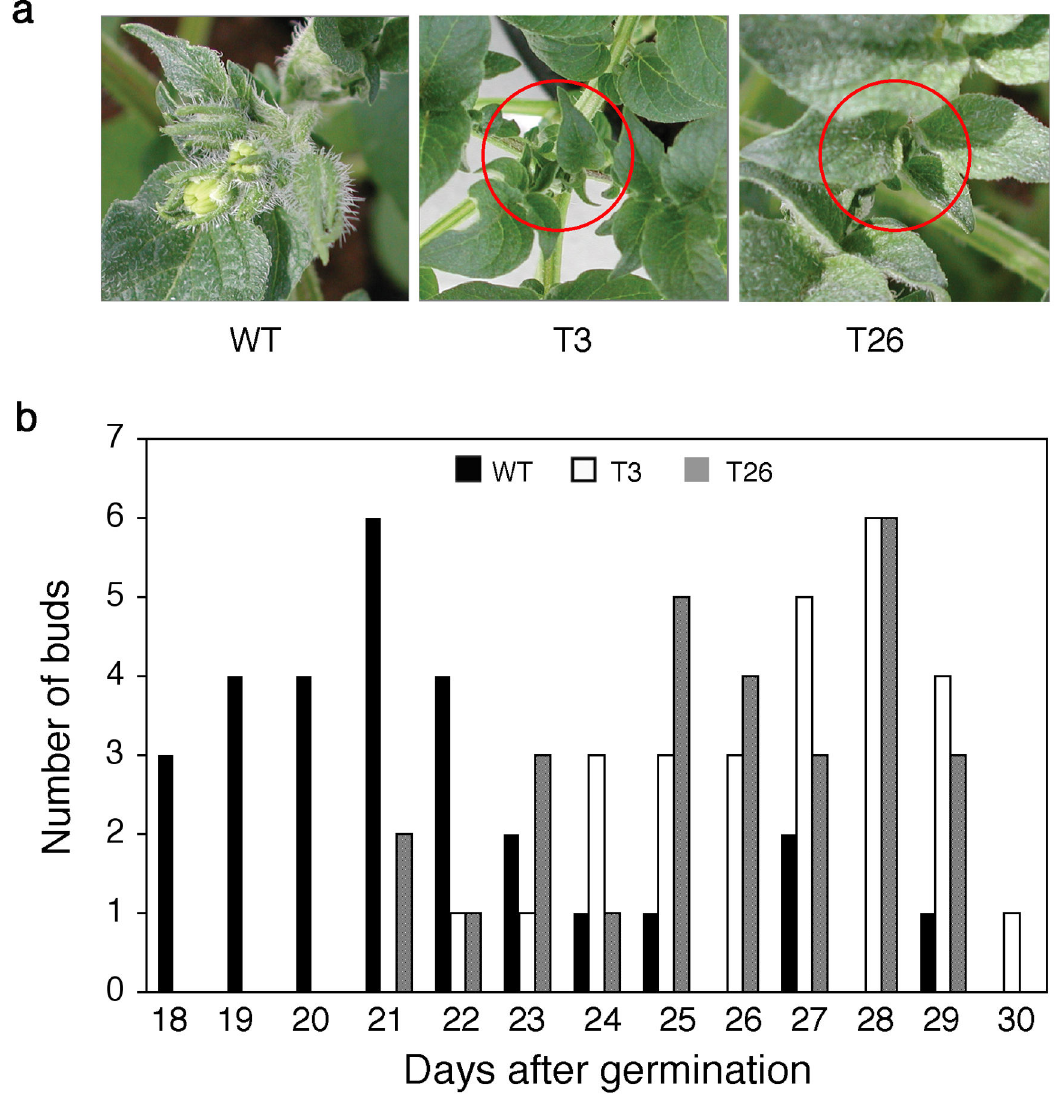
Figure 1. The development of floral buds is delayed in the msr A3-transgenics (T3 and T26). (a) Wild-type (WT) plant with the earliest emergence of a floral bud at 20 days after germination. The circles mark the terminal shoot of transgenics showing no signs of flower bud initiation. The buds were observed only on the main shoots from three replicated pots each having 3 plants grown in a growth chamber at day/night temperatures of 28 0 /22 0 C and 16/8 h light/dark cycle with light intensity of 300 µM quanta.m -2 .s -1 ; (b) Number of newly appeared buds after indicated days of germination. The buds were counted from six replicated pots each having 4-5 plants totaling 28. The plants were grown under natural light in green house with 16 h day length, and night and day temperature varied